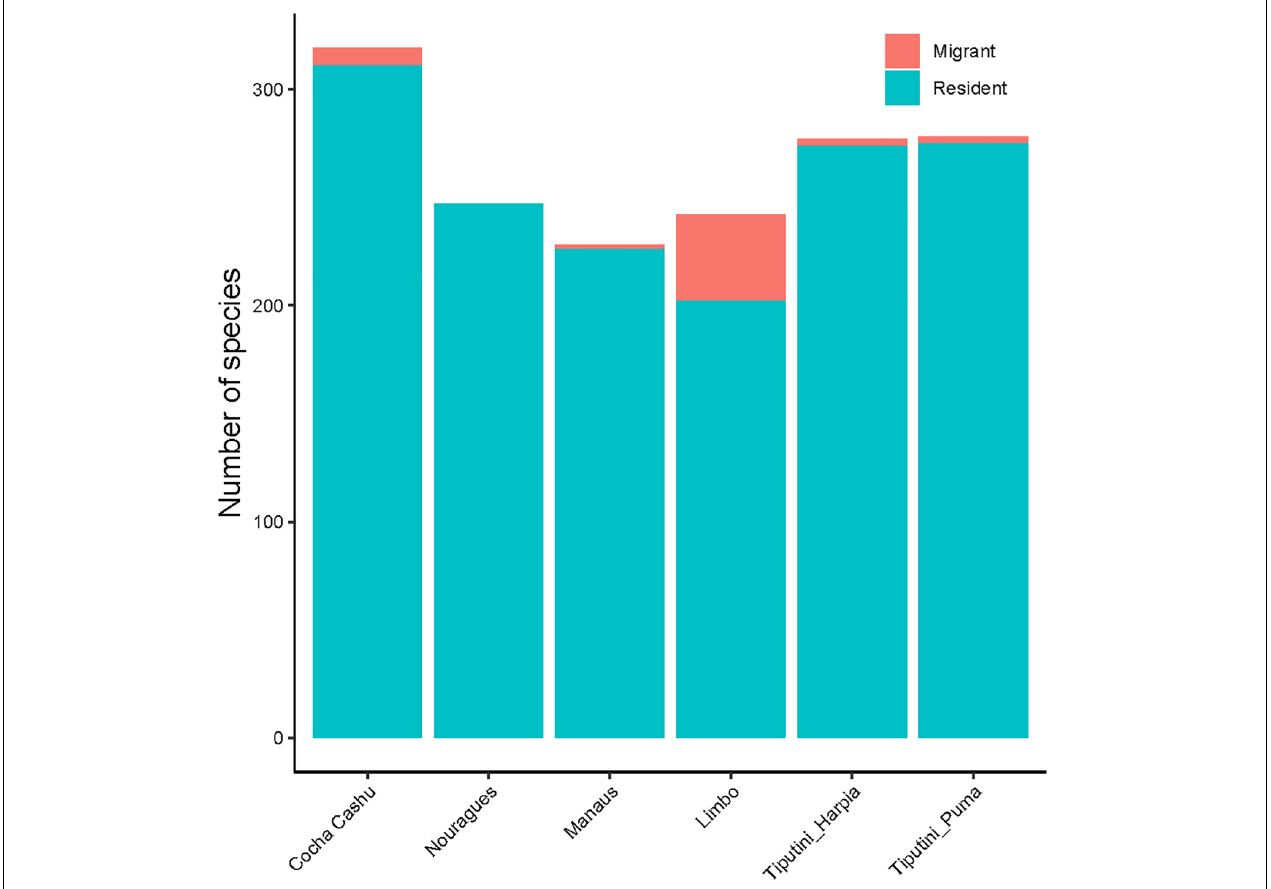
FIGURE 1 | Species richness of migrants and residents at six of the big Neotropical bird plots.